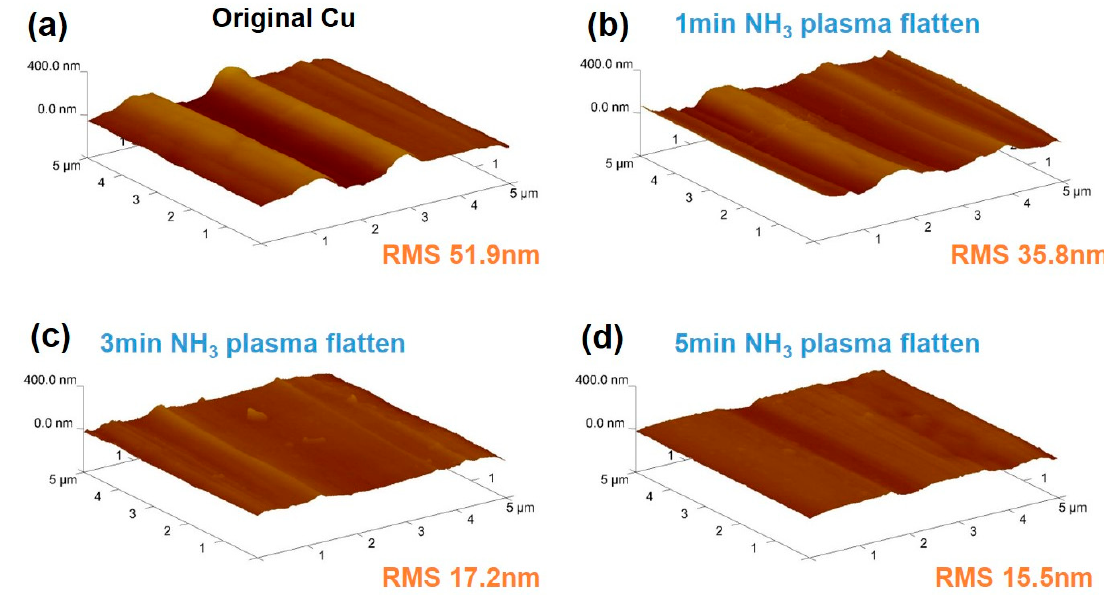
Figure 2. Atomic force microscopy (AFM) images of the Cu surface without and with NH 3 plasma treatment for different durations: ( a ) original Cu, ( b ) 1 min, ( c ) 3 min, and ( d ) 5 min. RMS is the abbreviation of roughness mean square.